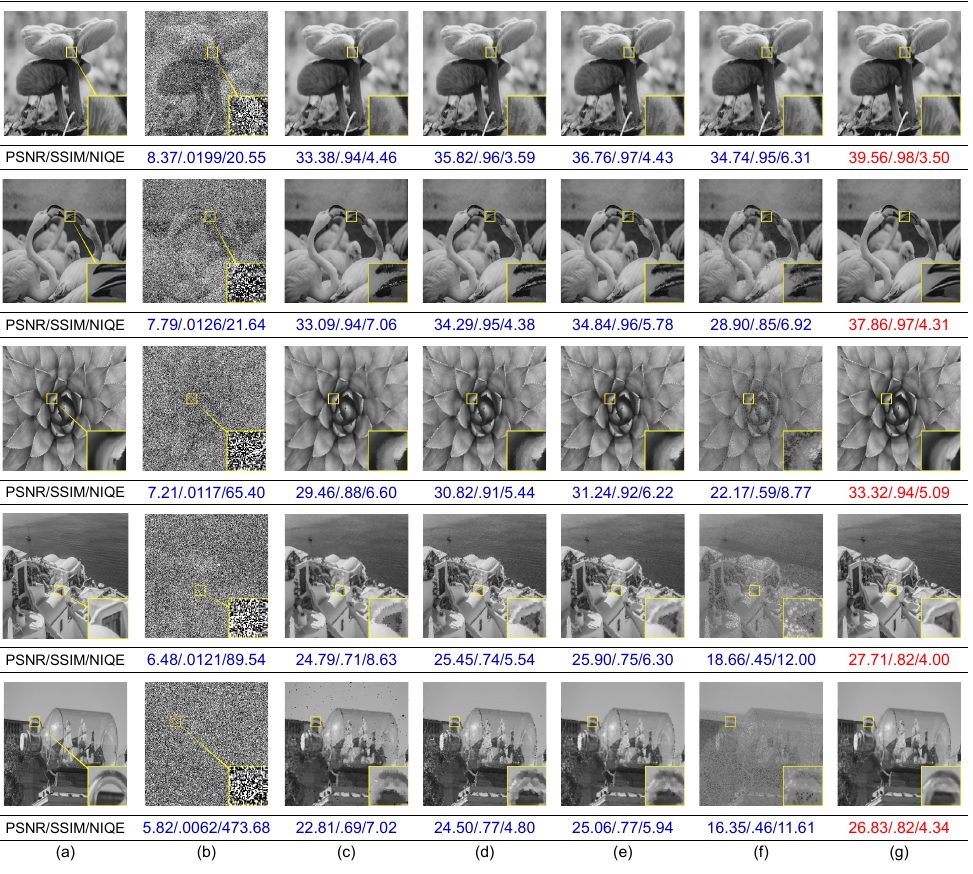
Figure 4. Examples of denoising results for images with 50-90% noise added using different methods. We show the corresponding objective scores below the measured images. The best scores are in red. ( a ) Original image. ( b ) Images with 50%, 60%, 70%, 80%, 90% noise added (from the top to bottom rows). Denoising results using ( c ) MDBUTMF [8], ( d ) DAMF [9] , ( e ) FASMF [10], ( f ) MMAP [11], and ( g ) the proposed